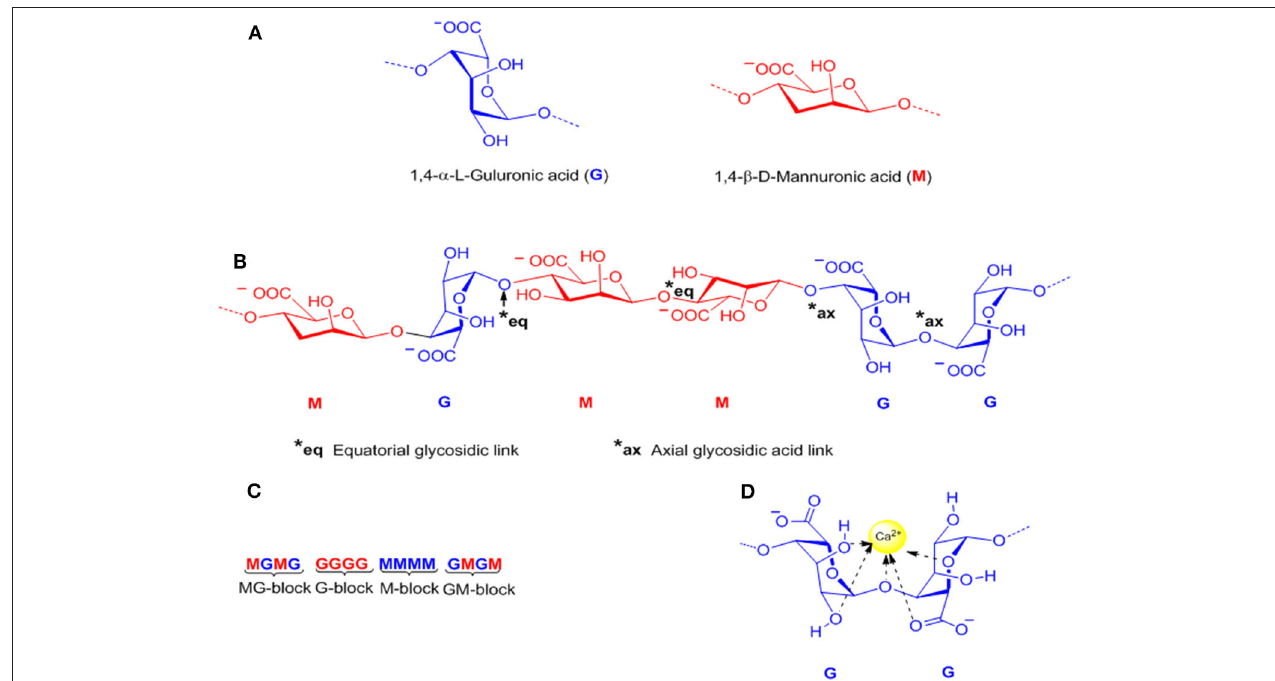
FIGURE 6 | Representative alginate structure: (A) Monomers, (B) Chain conformation, (C) Block distribution (M-block, G-block, and MG or GM block), and (D) Schematic model of hydrogel formation “egg-box